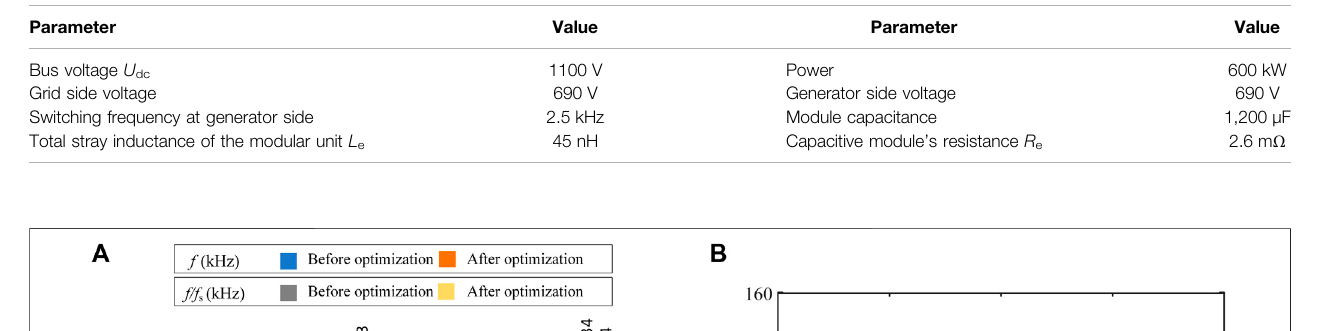
Frontiers in Energy Research |